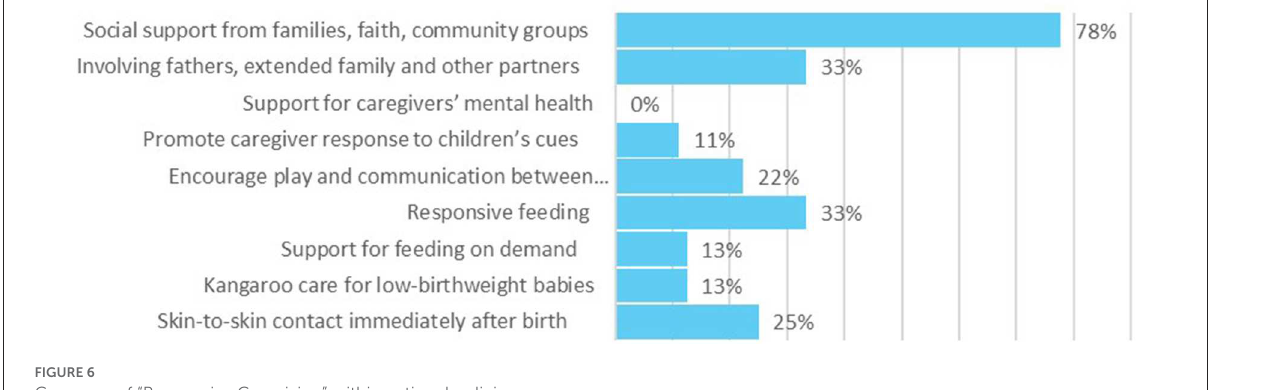
FIGURE6 Coverage of “Responsive Caregiving” within national